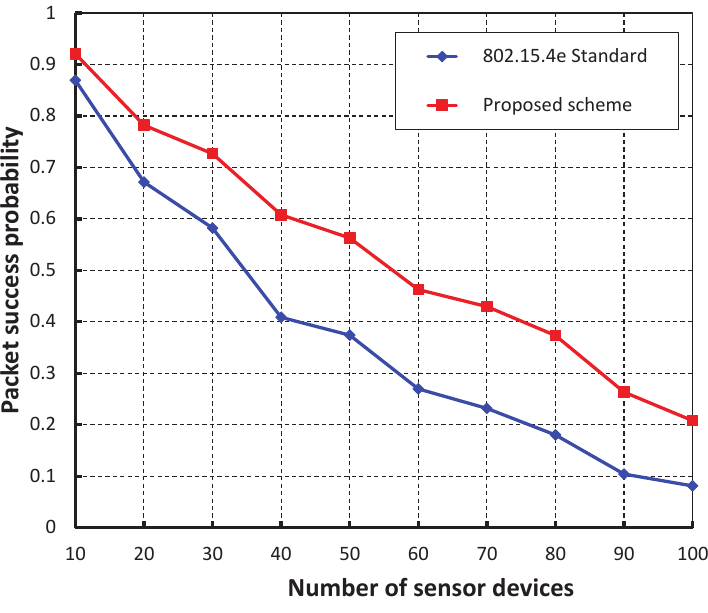
Figure 7. Comparison of packet success probability of our proposed scheme with the IEEE 802.15.4e standard.